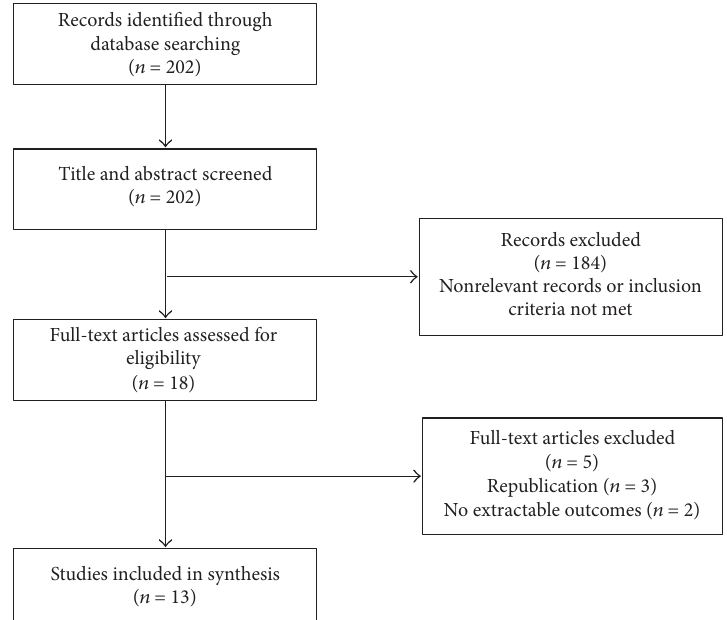
Figure 1: Flow diagram of study selection.